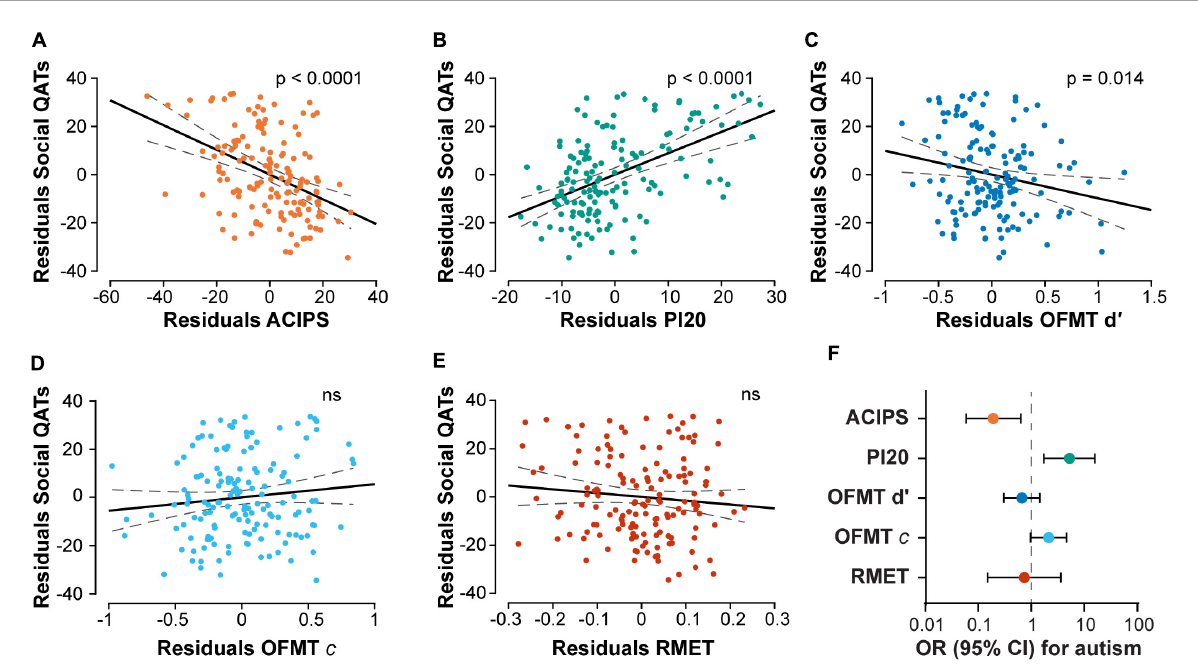
FIGURE3 Associations of social constructs with social QATs and diagnosed autism. Scatter plots show the partial correlations for social constructs, correcting for age, gender, ethnicity, and comorbidities. P -values are those of the individual coefficients; ns indicates that the model was not significant (full models are reported in Supplementary Tables 1–3 and in the section “Results”). (A) Social anhedonia quantified with the ACIPS; lower scores indicating higher anhedonia. (B) Prosopagnosic traits quantified with the PI20; higher scores correspond to higher prosopagnosia. (C) Face matching sensitivity quantified with the OFMT d (cid:48) . (D) Face matching response bias quantified with the bias c in the OFMT. (E) Mentalizing measured with the RMET. (F) Odds ratios and 95% confidence intervals for prediction of autism diagnosis by the social constructs. ACIPS, Anticipatory and Consummatory Interpersonal Pleasure Scale; OFMT, Oxford Face Matching Task; PI20, 20-item Prosopagnosia Index; RMET, Reading the Mind in the Eyes